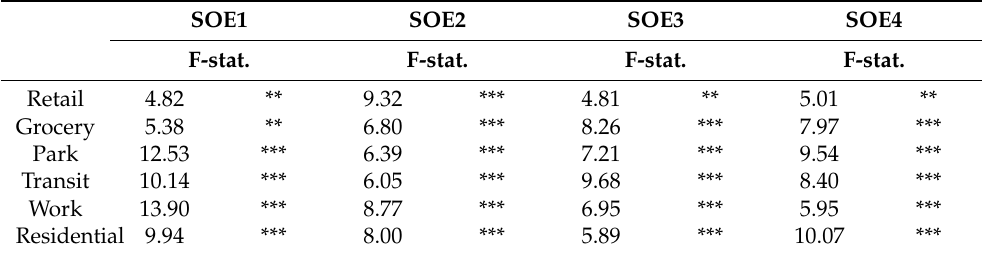
Table 6. ARDL bound test for